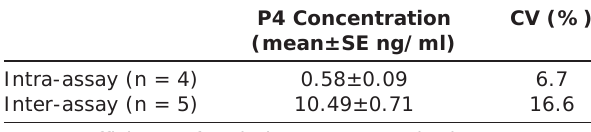
Table-2: Intra and inter-assay CV of P4-ECL